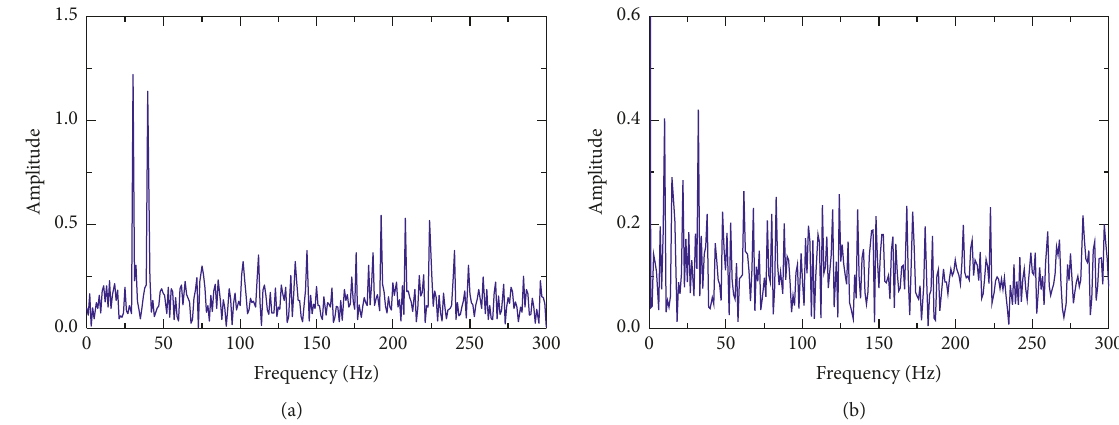
Figure 5: (a) FFT spectrum; (b) envelope spectrum for simulation signal y ( t )